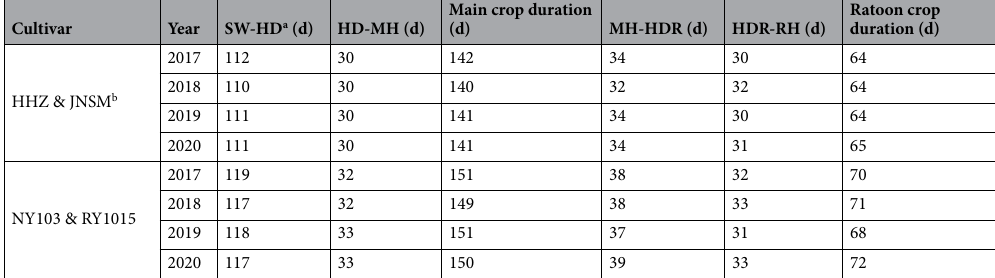
Table1. Growth duration of four rice cultivars in main rice crop -ratoon rice system in 2017–2020. a SW-HD, from sowing to heading; HD-MH, from heading to harvest of the main rice crop; MH-HDR, from harvest of the main rice crop to heading of the ratoon rice; HDR-RH, from heading of the ratoon rice to harvest of the ratoon rice. b HHZ, JNSM, NY103 and RY015 are Huanghuazhan, Jinnongsimiao, Nei6you103 and Rongyou1015,